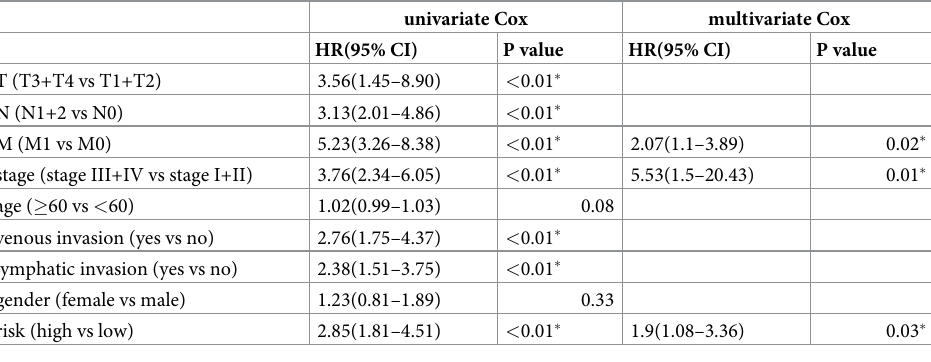
Table 3. A multivariate analysis of survival with clinical factors and the miRNA